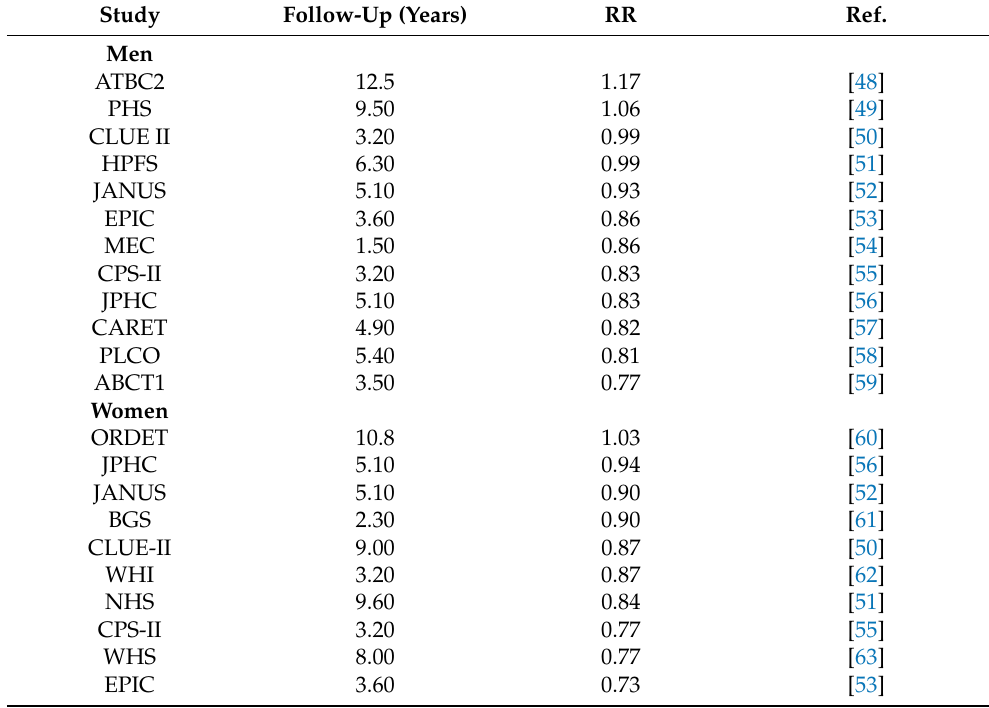
Table 4. Data related to Figure 2 in McCullough and colleagues